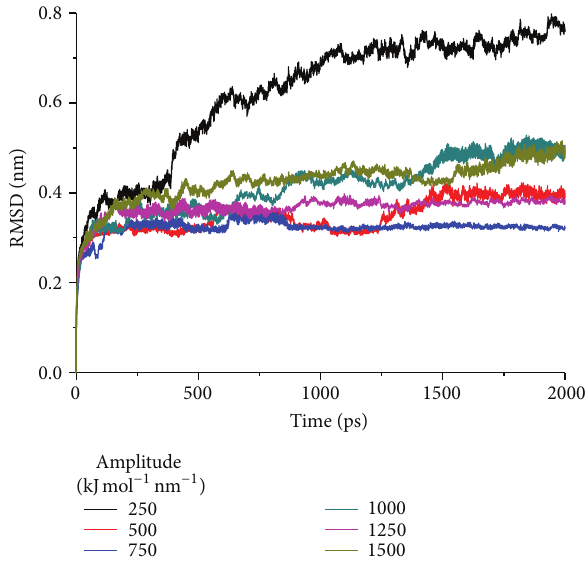
Figure 11: The RMSD curves of the VEMD simulations with varied amplitudes.